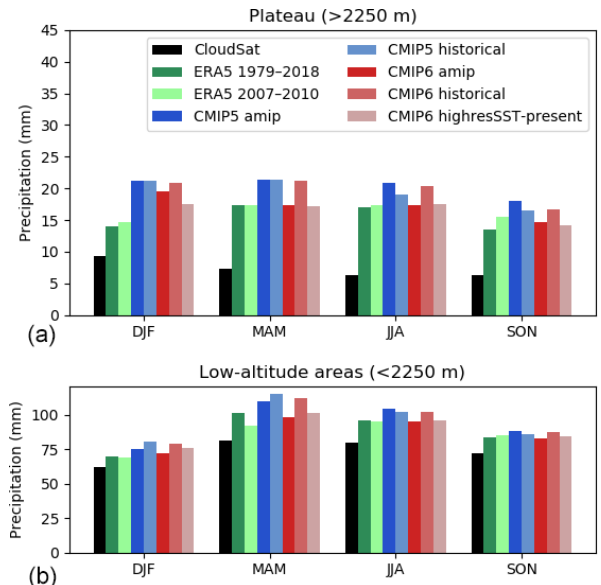
Figure 3. Seasonal averages of the observed mean 2007–2010 CloudSat, mean ERA5 (random and 2007–2010 averages), and en- semble median long-term average CMIP5 and CMIP6 snowfall rates per season for the plateau areas (a) and the low-lying reaches of the continent (b)